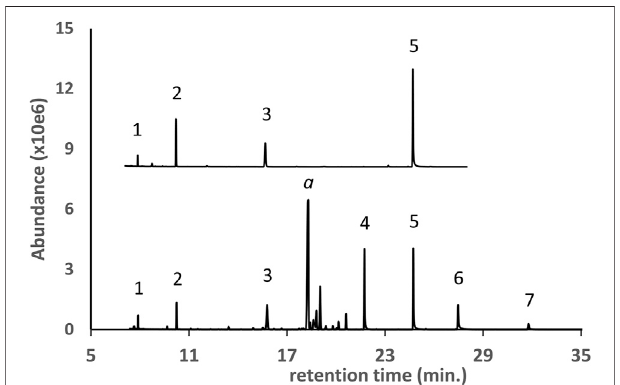
FIGURE 4 | GC-MS chromatogram for a vaping liquid ( lower trace ) in which a series of pine rosin acids (peak labels 1 through 6) were identi fi ed as the monoTMS derivatives. A gum rosin standard material ( upper trace , condensed scale, offset) is shown for comparison. Speci fi c pine rosin acids identi fi ed as follows: 2- isopimaric acid; 4- dehydroabietic acid; 5- abietic acid. The vaping liquid contained predominant amounts ofd9THC and CBN (peak labels a and b), as well as MCT oil components (not shown).